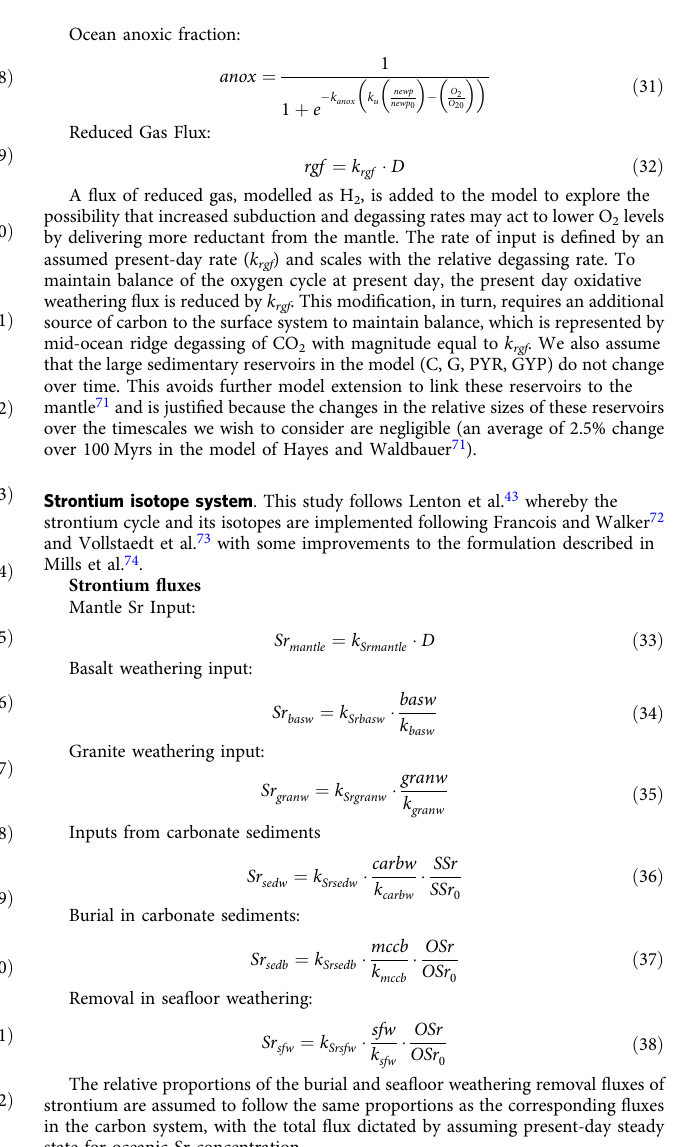
The relative proportions of the burial and sea fl oor weathering removal fl uxes of strontium are assumed to follow the same proportions as the corresponding fl uxes in the carbon system, with the total fl ux dictated by assuming present-day steady state for oceanic Sr concentration. Output from metamorphism: